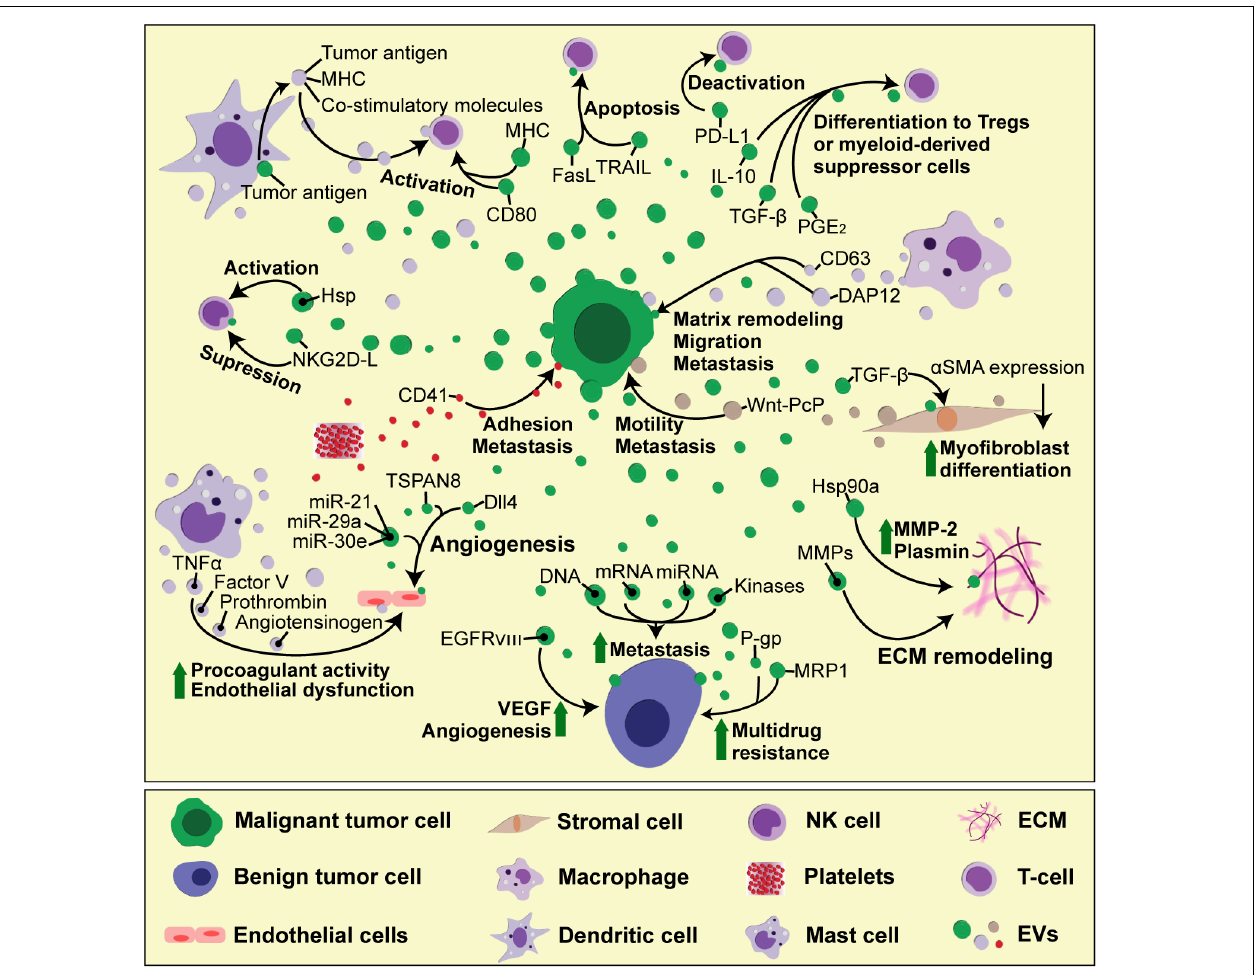
FIGURE 2 | The complexity of cell-to-cell interactions in tumor microenvironment mediated by EVs. During tumor progression, different cell types found in tumor microenvironment — including tumor, stromal, immune and vascular cells — interact reciprocally with each other, as well as with the ECM components, through EVs. These interactions result in immune cell activation or deactivation, which can either hamper or promote tumor growth, depending on the availability of soluble factors, which modulate the microenvironment status. In addition, tumor cell-derived EVs can spread drug resistance and invasive characteristics to other tumor cells, thus boosting tumor growth and the ability to form pre-metastatic